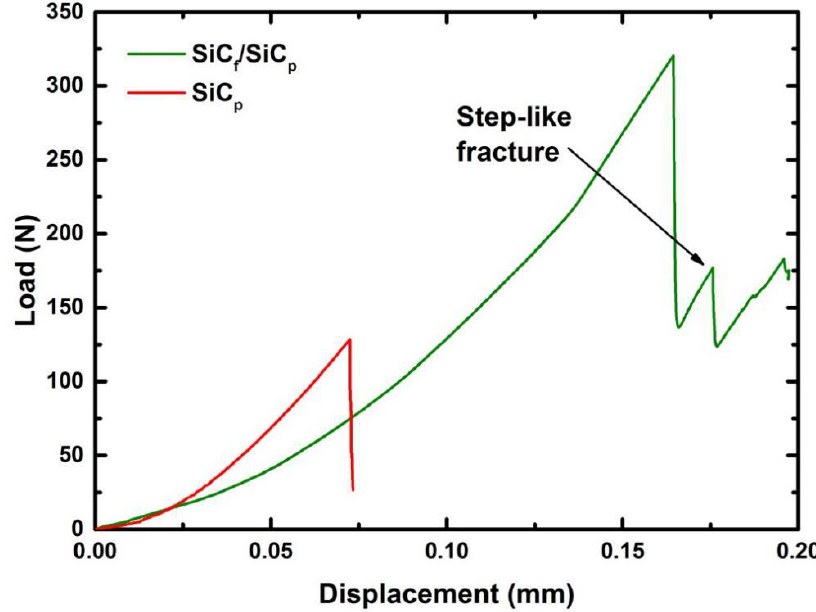
Figure 11. The load–displacement curves of the fiber-free preceramic paper-derived SiC p and SiC f / SiC p composite sintered at 40 MPa for 10 min.